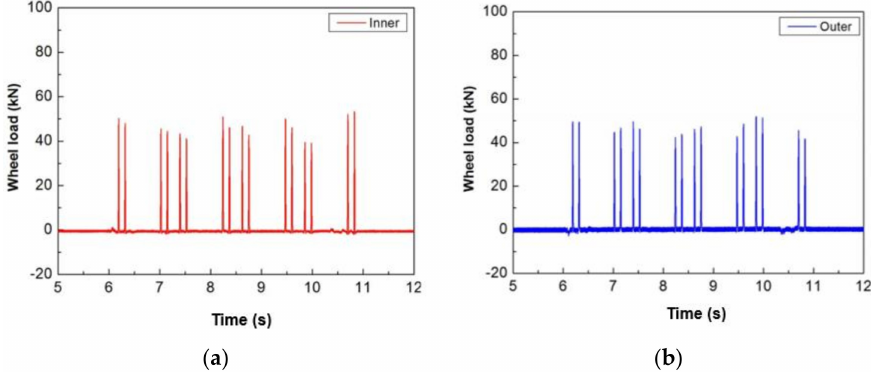
Figure 5. Examples of measured dynamic wheel load. ( a ) Inner rail; ( b ) Outer rail.